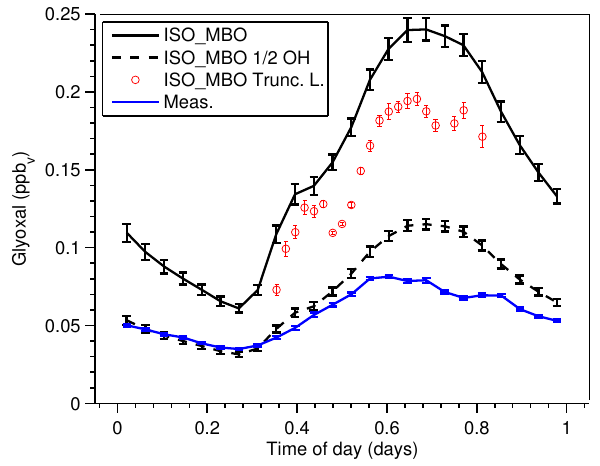
Fig. 6. Model results for OH sensitivity study. Simulations were performed using measured OH and 1 / 2 measured OH using com- bined isoprene and MBO chemistry. The Truncated Lagrangian model (daytime only) is shown for comparison. Error bars indi- cate the 1 standard deviation envelope as calculated based on the variability in the data and model outputs, not reported errors.